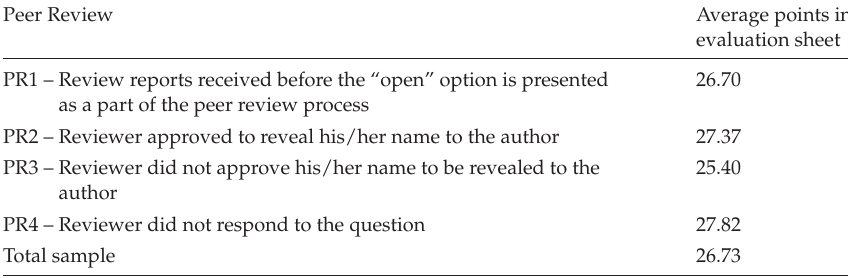
Table 13: Average points in evaluation sheet in the groups of peer reviews reports.